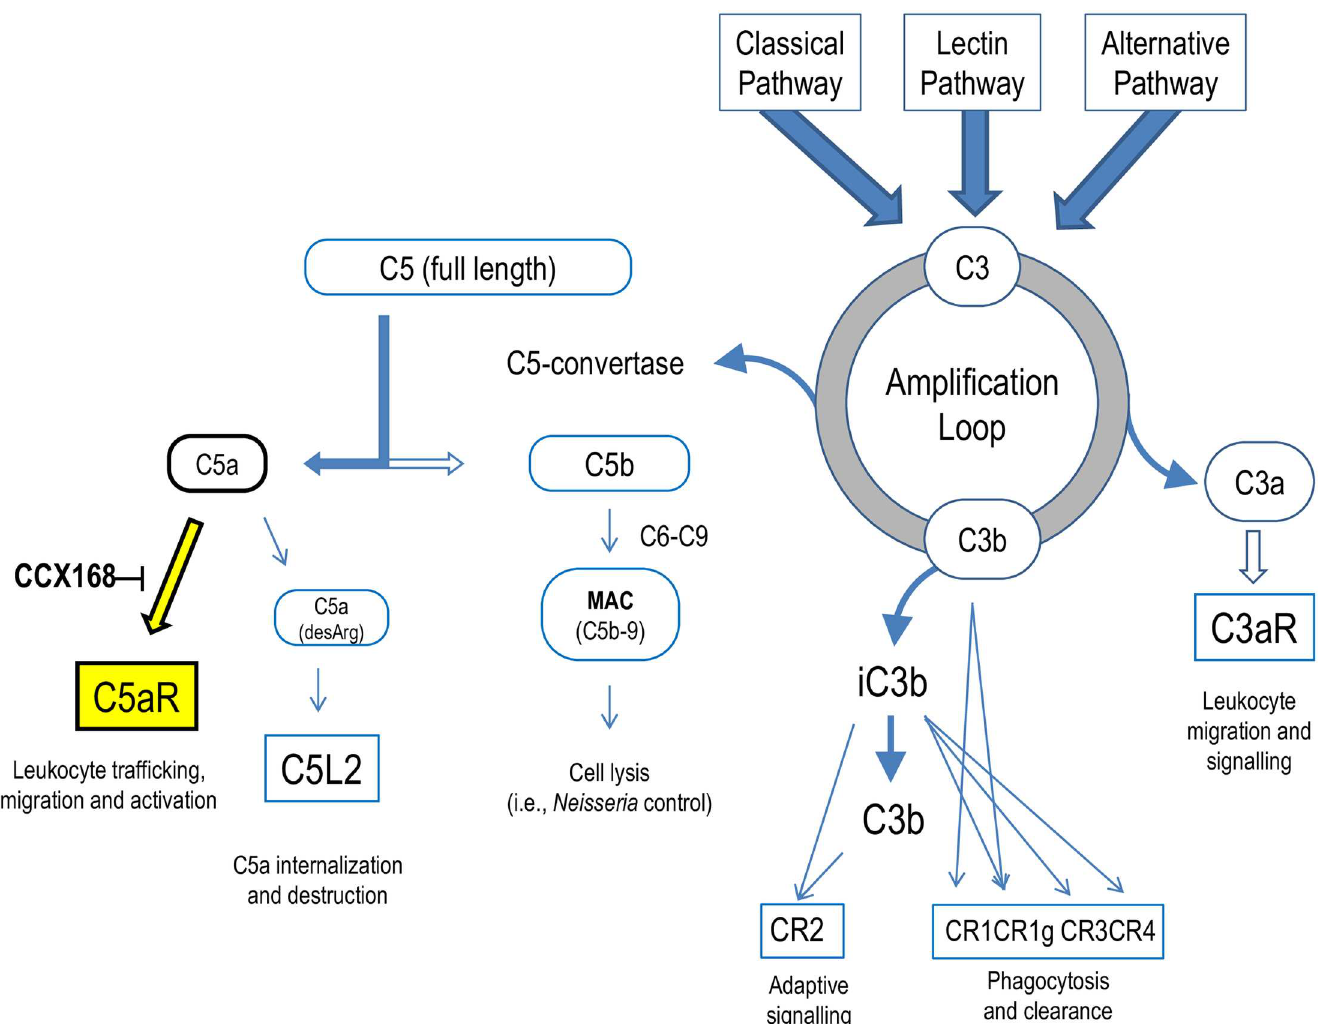
Fig 2. The Complement Cascade Showing the Point of Intervention of CCX168. The complement cascade can be activated by the classical, lectin, or alternativepathways and leads to the formation of C3a, C3b, C5b-9 (terminal complement complex) and C5a. During the amplification loop, full length C3 is cleaved to form C3a and C3b; C3aR is the G protein coupled expressed receptor that responds to C3a, while C3b covalently binds to foreign surfaces and aids in phagocytosis and clearance. C5 convertase is formed during the amplification loop, leadingto the cleavageof full length C5 at a specific arginine-leucine bond to form C5a and C5b. C5b associates with complement components C6, C7, C8, and C9 to form the terminal complement complex or membrane attack complex (MAC), typically on the surface of pathogenic bacterial cells. C5aR (CD88) is the G protein coupled receptor expressed by innate immune cells, such as neutrophils, that responds to C5a (12 kDa), a potent pro-inflammatory mediator [2,11]. C5a rapidly induces expression of adhesionmoleculeson the cell surface of innate immune cells, such as neutrophils, and induces the directed migration, or chemotaxis, of these cells. C5a also mediates inflammation by stimulating vascular permeability, neutrophildegranulation, and release of lysosomal proteasesand oxidative free radicals [8]. C5a is a transient molecule, being rapidly degradedof its carboxy terminal arginine[12], and hence losing about 10-fold activity on C5aR, and then being internalizedand degradedvia C5L2, a 7 trans-membrane receptor that has an anti-inflammatory role [13–17]. CCX168 is a small moleculeantagonistof C5aR that selectivelyand competitively binds to this